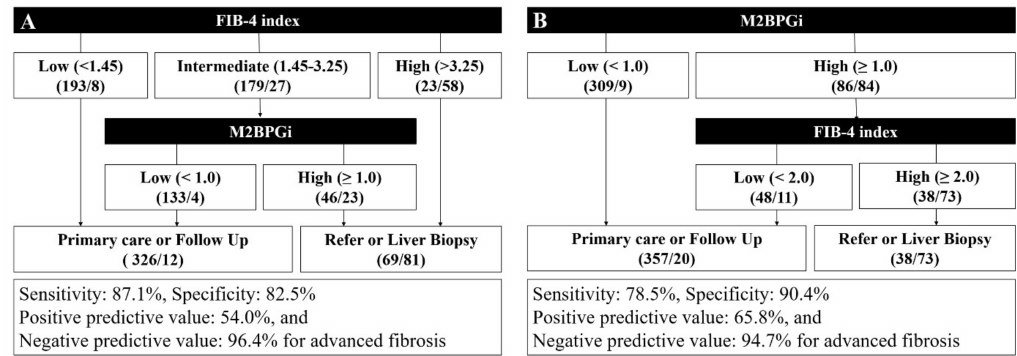
Figure 5. Proposal of two diagnostic algorithms for advanced liver fibrosis. ( A ) The M2BPGi value was incorporated following the FIB-4 index. ( B ) The FIB-4 index was incorporated following the M2BPGi value. The numbers in parentheses represent (the number of patients without advanced hepatic fibrosis / the number of patients with advanced hepatic